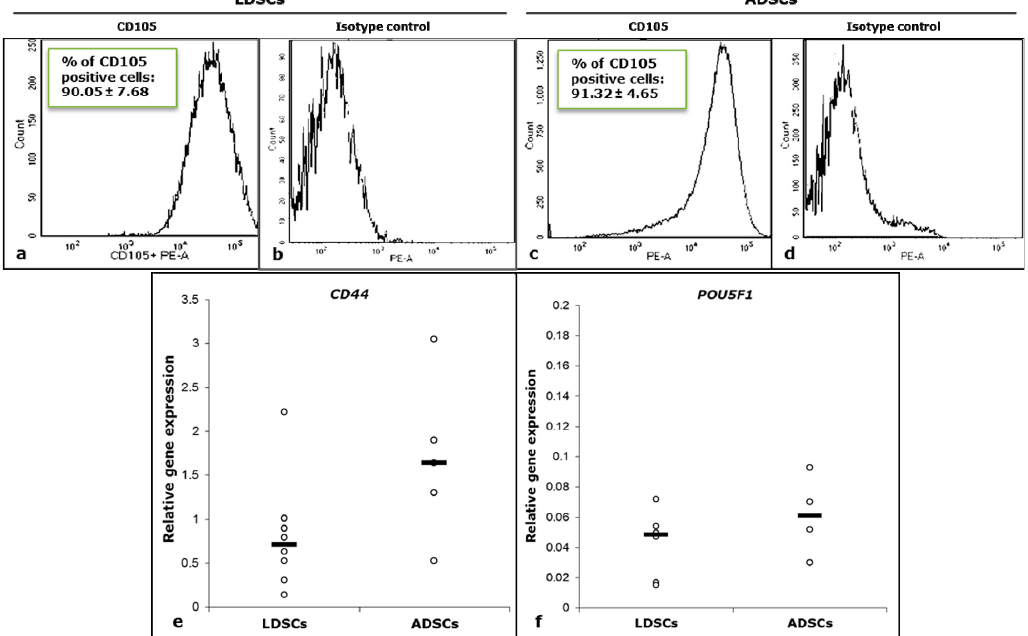
Figure 2. Flow cytometric analysis of CD105 cell surface marker expression in LDSCs ( a ) and ADSCs ( c ) at passage 2 (representative histograms per each group of samples with % of CD105 positive cells presented as mean ± SD, n (LDSCs) = 6 and n (ADSCs) = 4); corresponding isotype controls ( b , d );